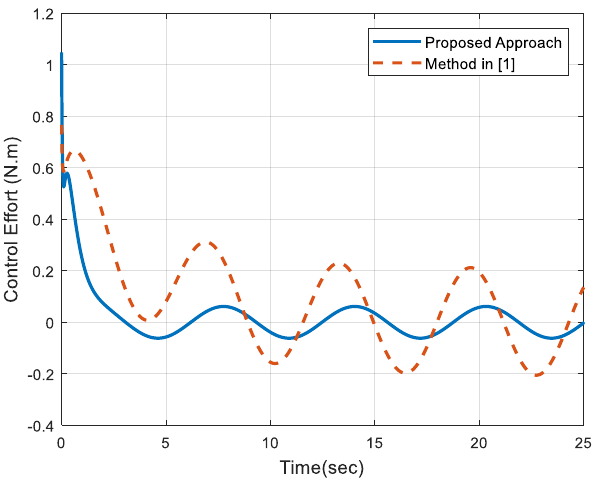
Figure 8. Controller effort of proposed technique in comparison with the method of Golestani et al., 2020 [1].